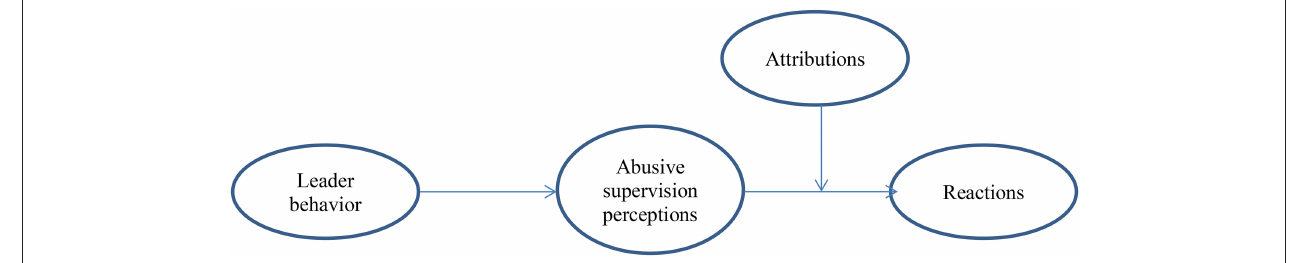
FIGURE 1 | Research